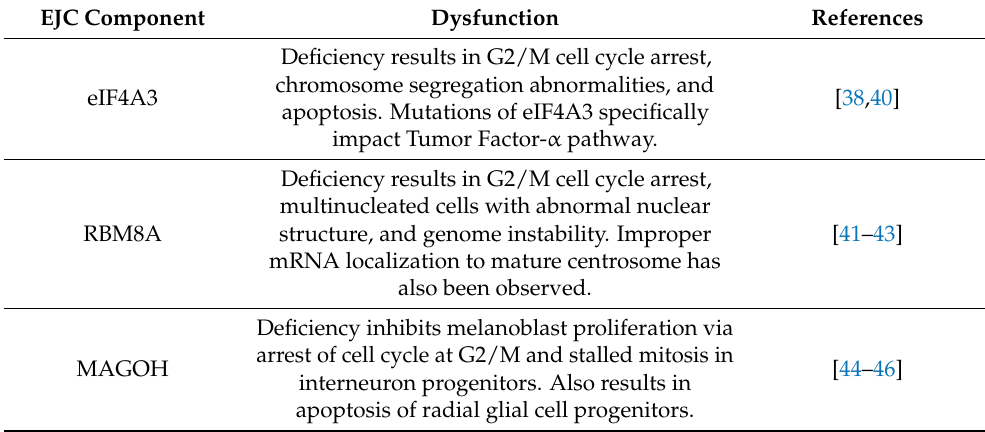
Table 2. Summary of cell cycle abnormalities caused by dysfunction of core EJC components. Included are key references in which EJC cell cycle abnormality is detailed.